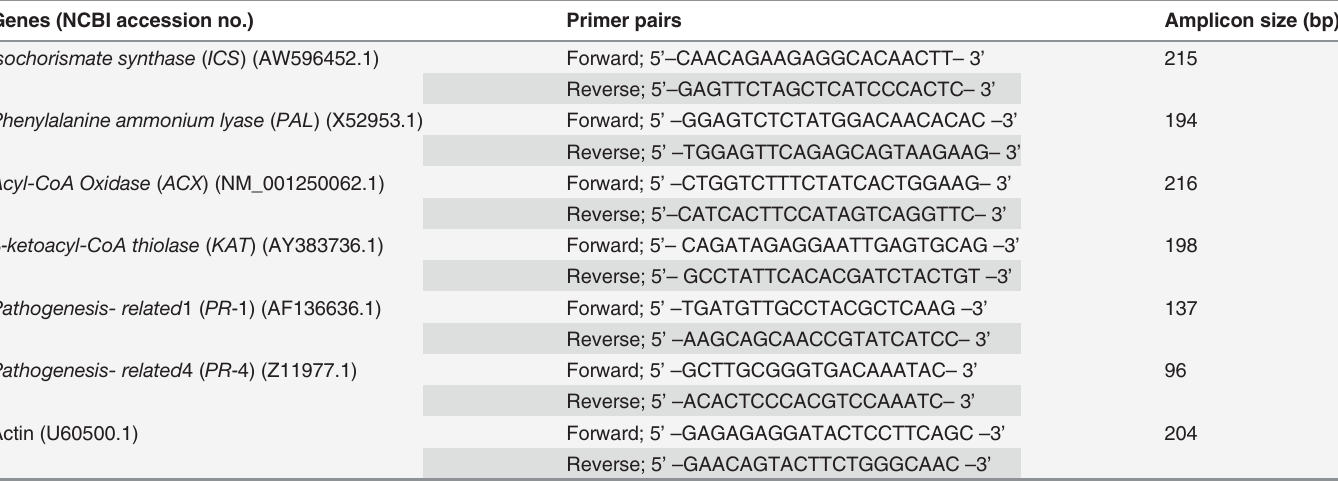
Table 1. Primers used for PCR and their amplicon